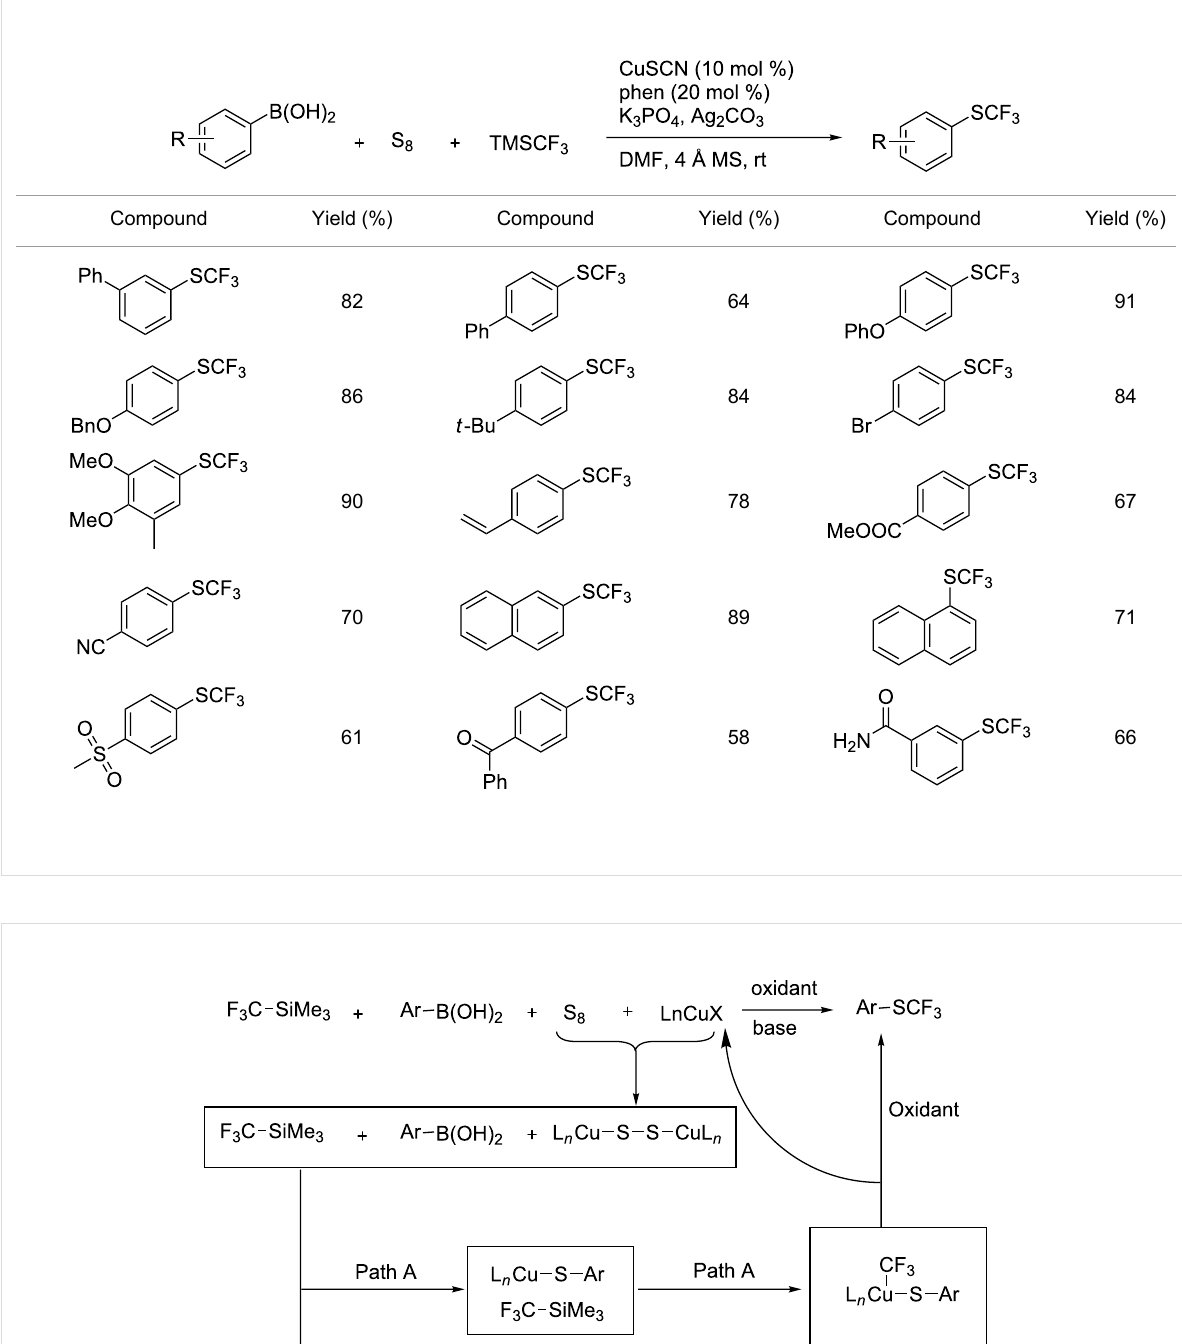
Table 43: Cu-catalyzed oxidative trifluoromethylthiolation of aryl boronic acids with TMSCF 3 and elemental sulfur [135].